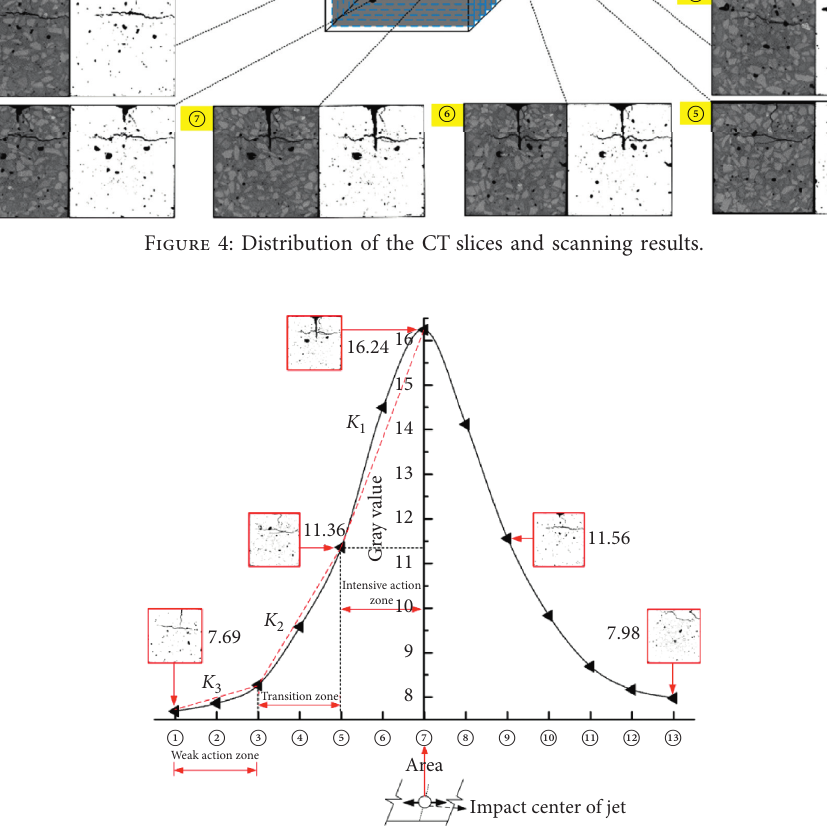
Figure 5: Variation curve of the average grey value of CT